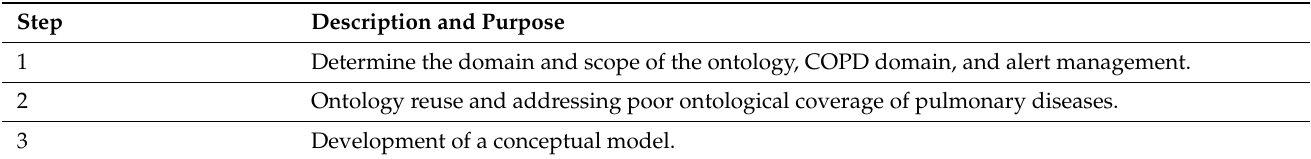
Table 3. The steps in Sanchez’s proposal.